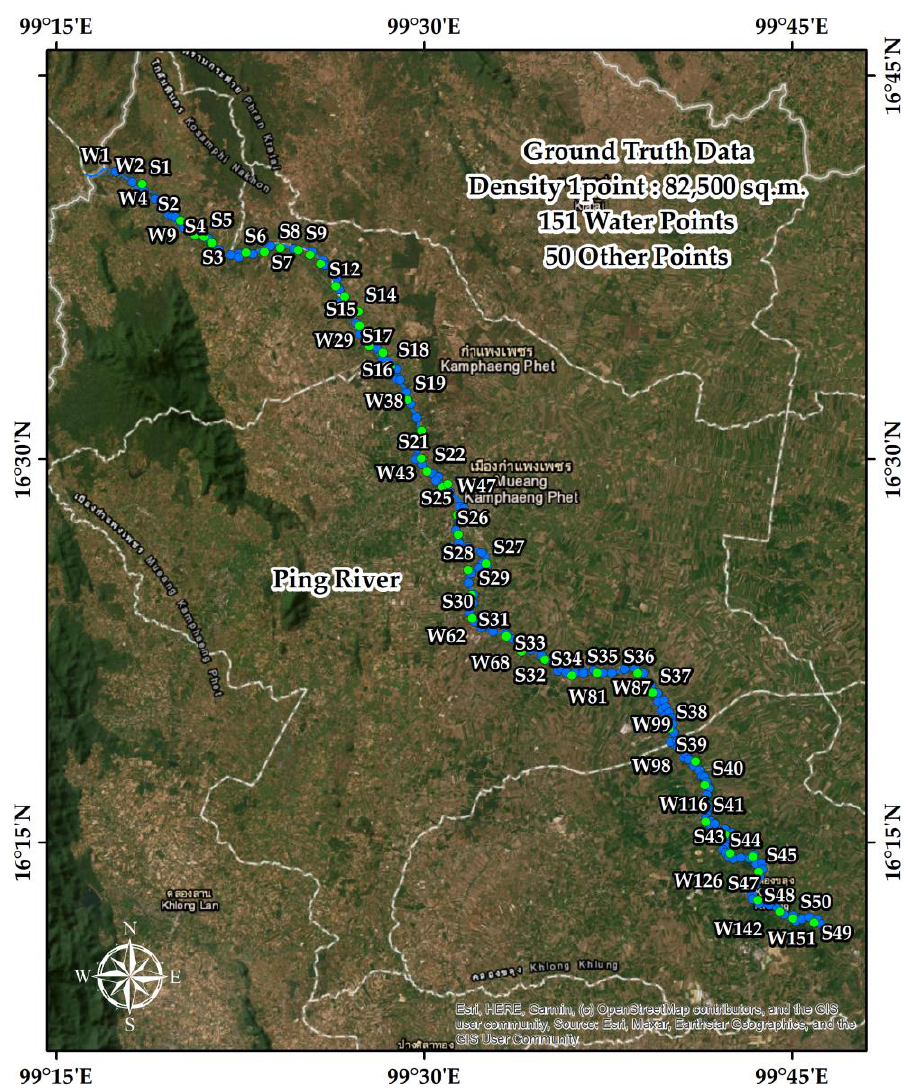
Figure 5. Ground truth data in 2022 comprising water points (blue) and soil area sites (green).